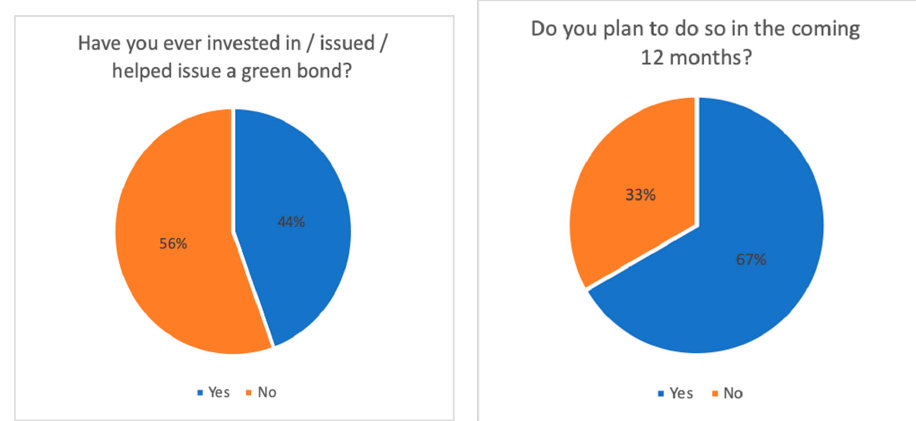
Figure 1. Overview of issuance in our survey. Source: based on interviews with 11 experts across issuers, investors, and intermediaries, conducted in December 2019.